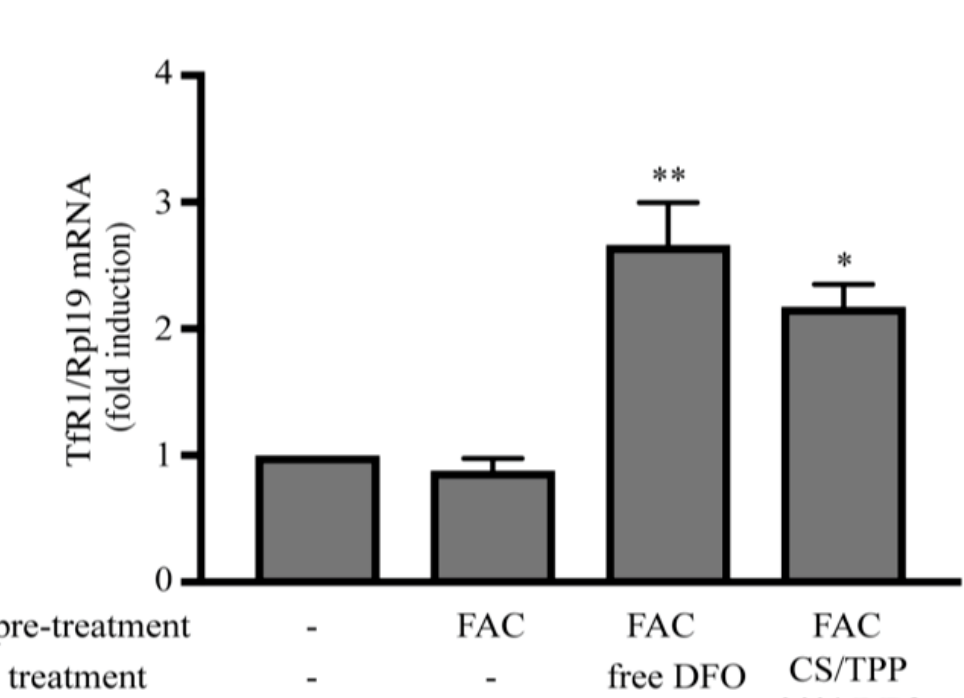
Figure 11. CS / TPP NP-encapsulated DFO promotes induction of TfR1 mRNA in RAW 264.7 Figure 11. CS/TPP NP-encapsulated DFO promotes induction of TfR1 mRNA in RAW 264.7 macrophages.